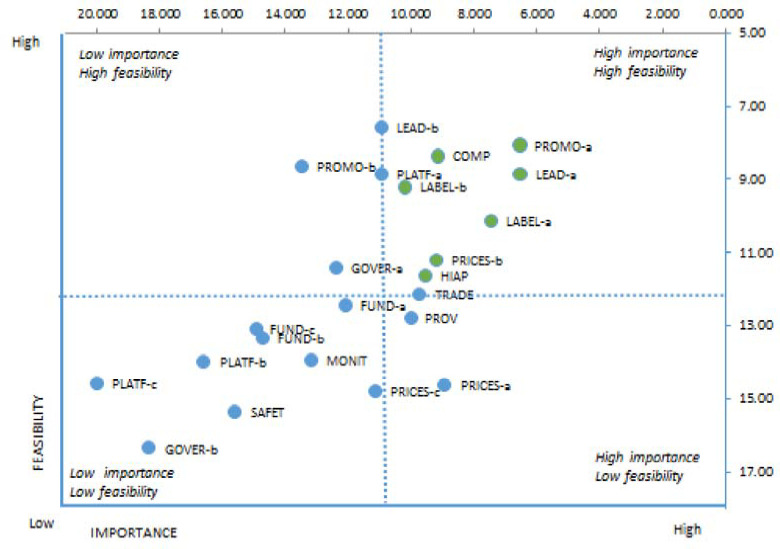
Final list of recommended actions for government in terms of importance and feasibility.